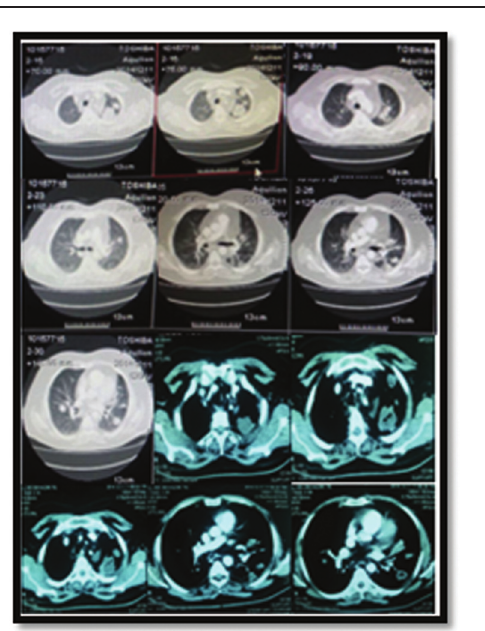
hancing soft tissue